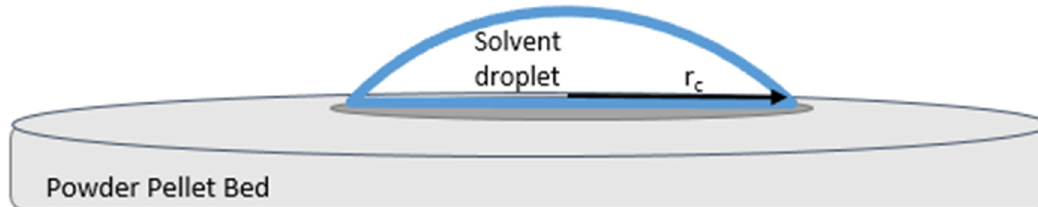
Figure 2. View of a sessile drop as the liquid penetrates into the dry nanoparticle bed and begins wetting the surface using the drop penetration method.